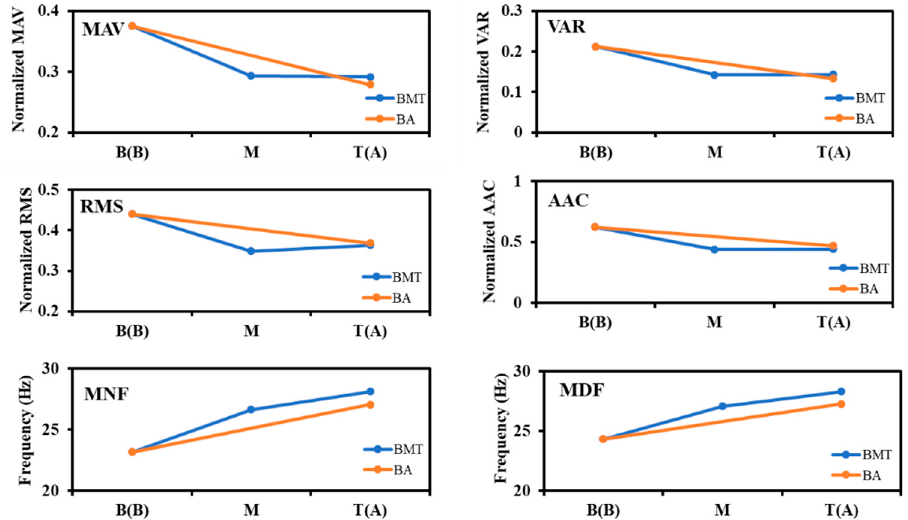
Figure 6. Comparison of the force plate experiment results of the present study with our previous research